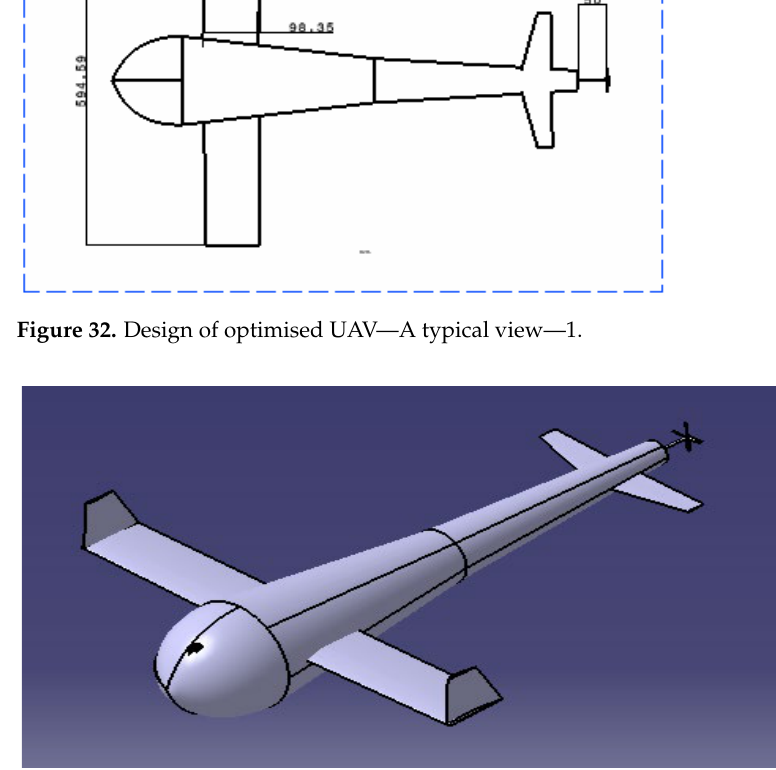
Figure 33. Conceptual design of optimised UAV.